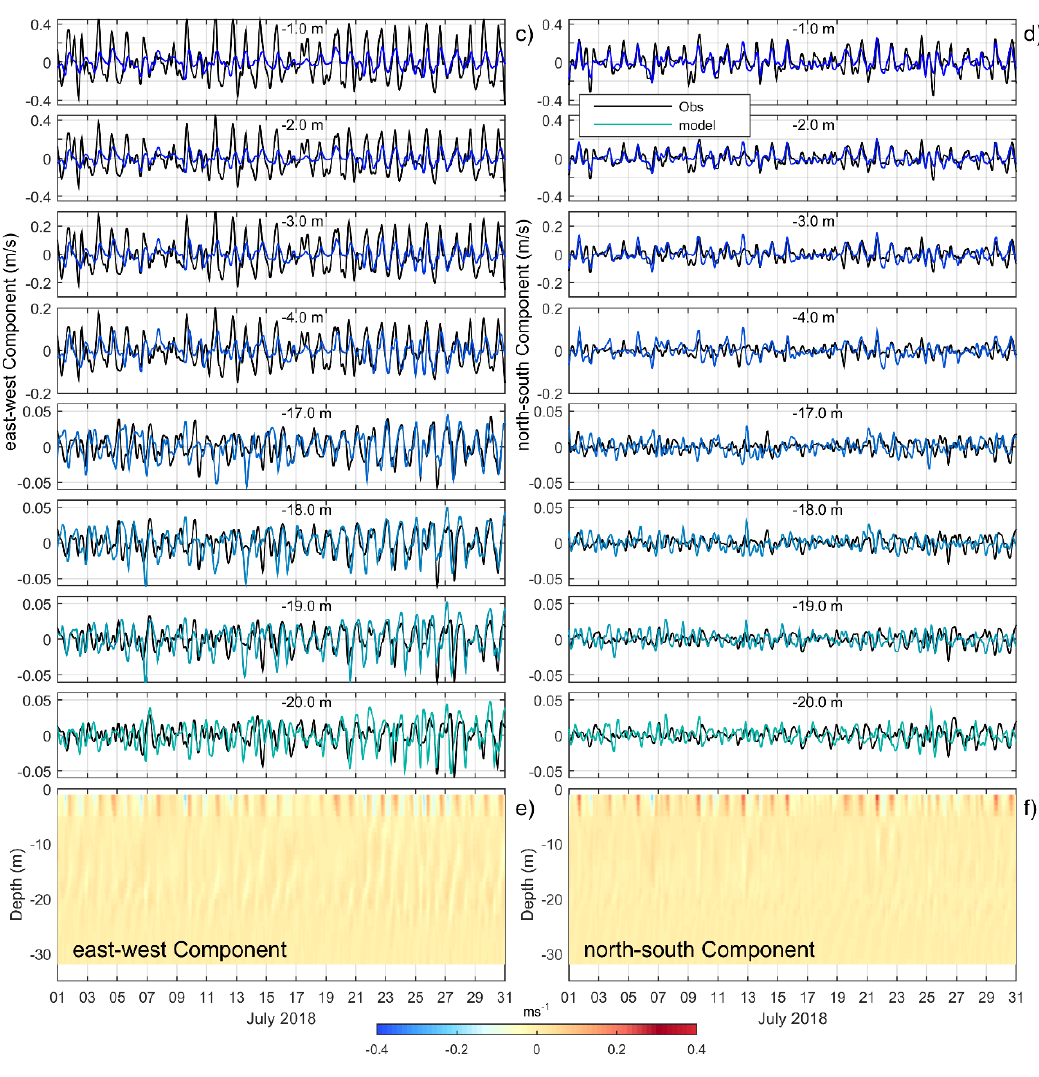
Figure 15. Comparison of water temperature measured ( a ) and predicted ( b ) from June 2018; in ( c ), the velocity component u; and in ( d ), the velocity component v from July 2018, the measured data are shown in black and the predicted data in blue. In ( e ) and ( f ), velocity components from the numerical results for July.